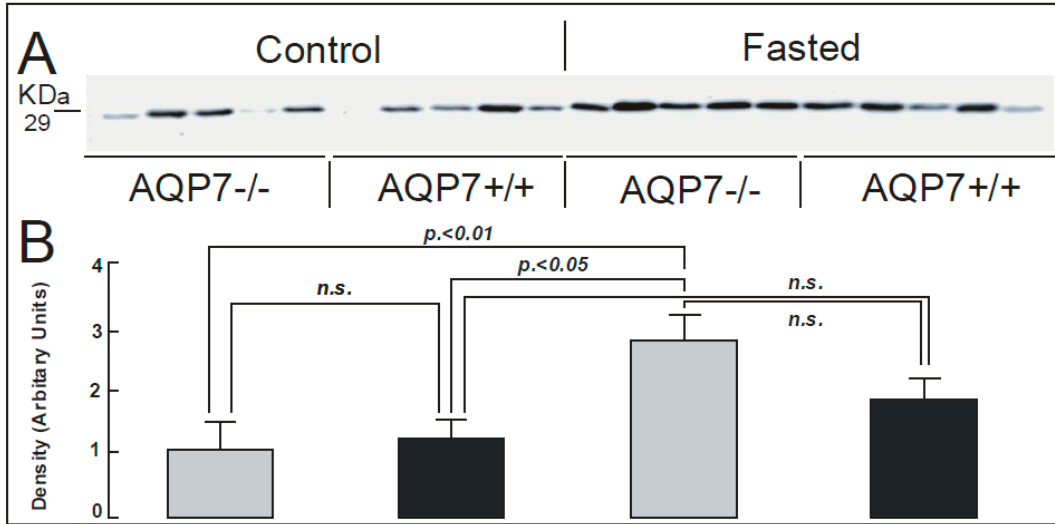
Figure 2. Western blot analysis of AQP1 protein expression in capillary endothelia of WAT from control and fasted mice (control: AQP7 − / − , AQP7+/+; fasted: AQP7 − / − , AQP7+/+). Anti-AQP1 antibody recognizes a ~29 kDa band in membrane fractions from mouse WAT ( A ). Densitometric analysis of AQP1 was performed and normalized against total protein amount ( B ).